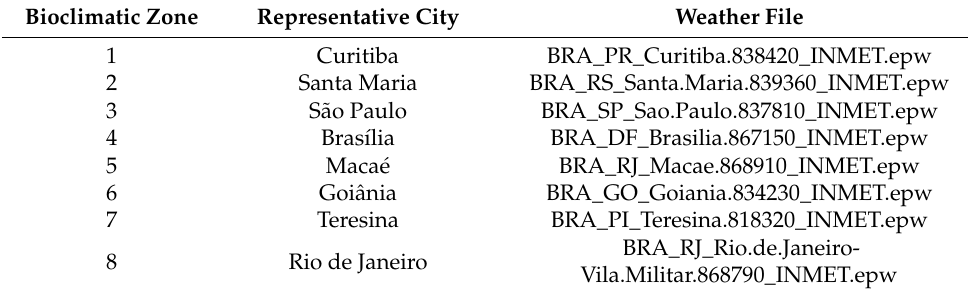
Table 1. Representative cities for the Brazilian bioclimatic zones [18,19].